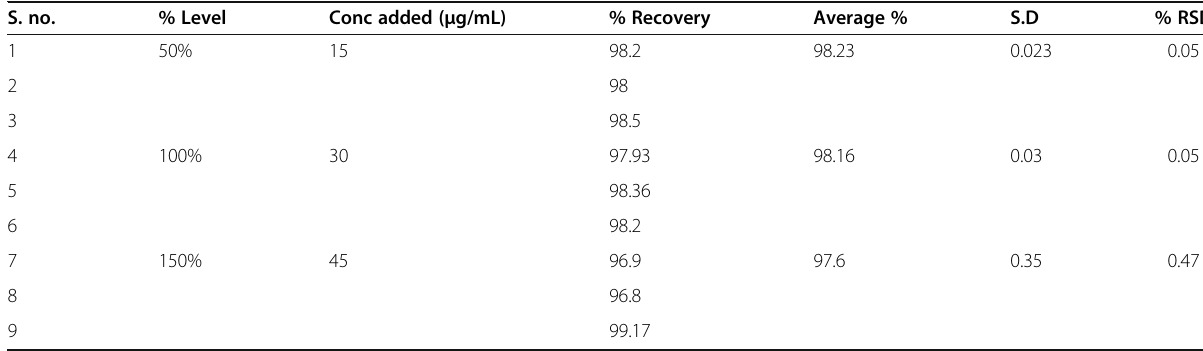
Table 7 %Recovery of Tezacaftor in human plasma S. no.